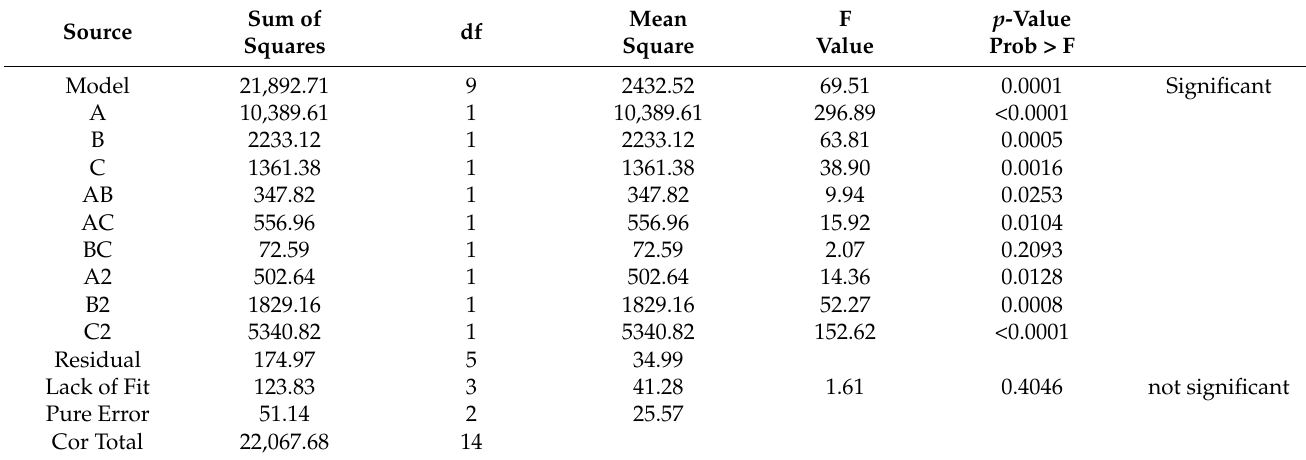
Table 6. ANOVA for the response surface quadratic model.